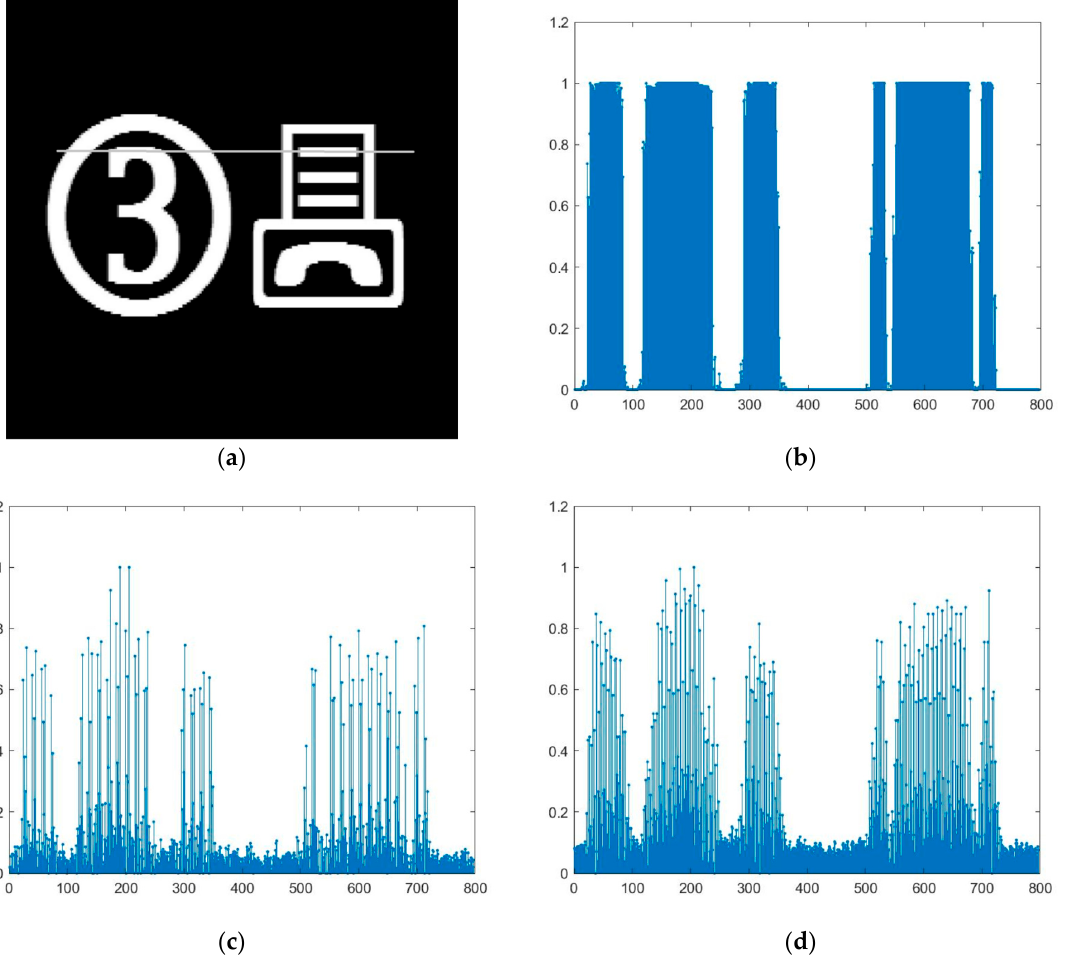
Figure 8. ( a ) A row in the source image, highlighted in grey, ( b ) intensity variation of the row of pixels in highlighted in ( a ), ( c ) intensity variations of the row of pixels of the reconstructed image of the SPOH with down-sampling factor 𝜏 = 16, ( d ) intensity variations of the row of pixels of the reconstructed image of the SPOH after applying our proposed TDCF.